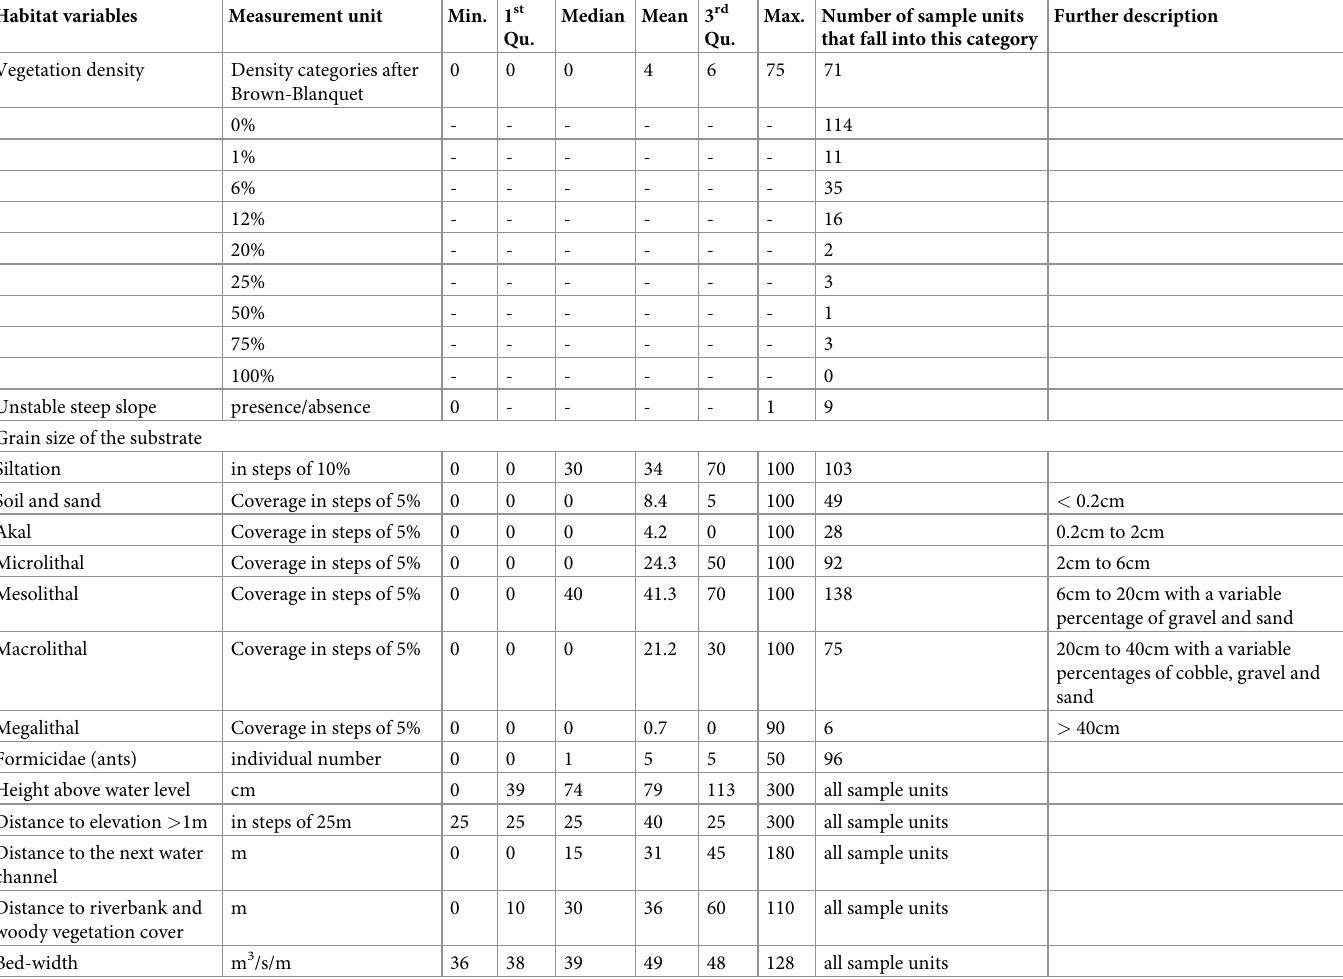
Table 1. Recorded habitat variables on each of the 185 sample units. Minimum (Min), quartiles (QU), maximum (Max) and mean are given for all samples and each variable. Habitat